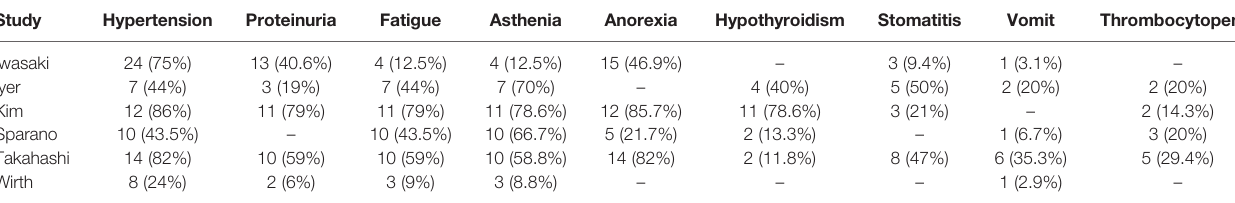
TABLE 4 | Safety measurements in each study.